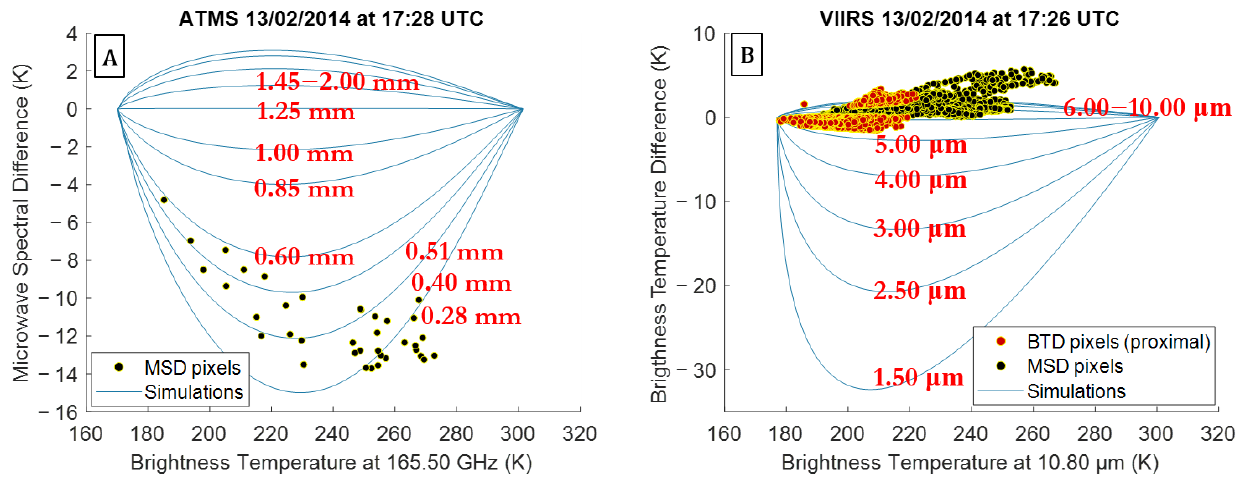
Figure 9. The Kelud eruption on 13th February 2014 at 17:28 UTC. ( A ) The simulated arch curves for MW-MMW observations. ( B ) The simulated arch curves for TIR observations. The black points represent ash pixels identified using the MSD method. The orange pixels highlight the pixels detected using the BTD method.